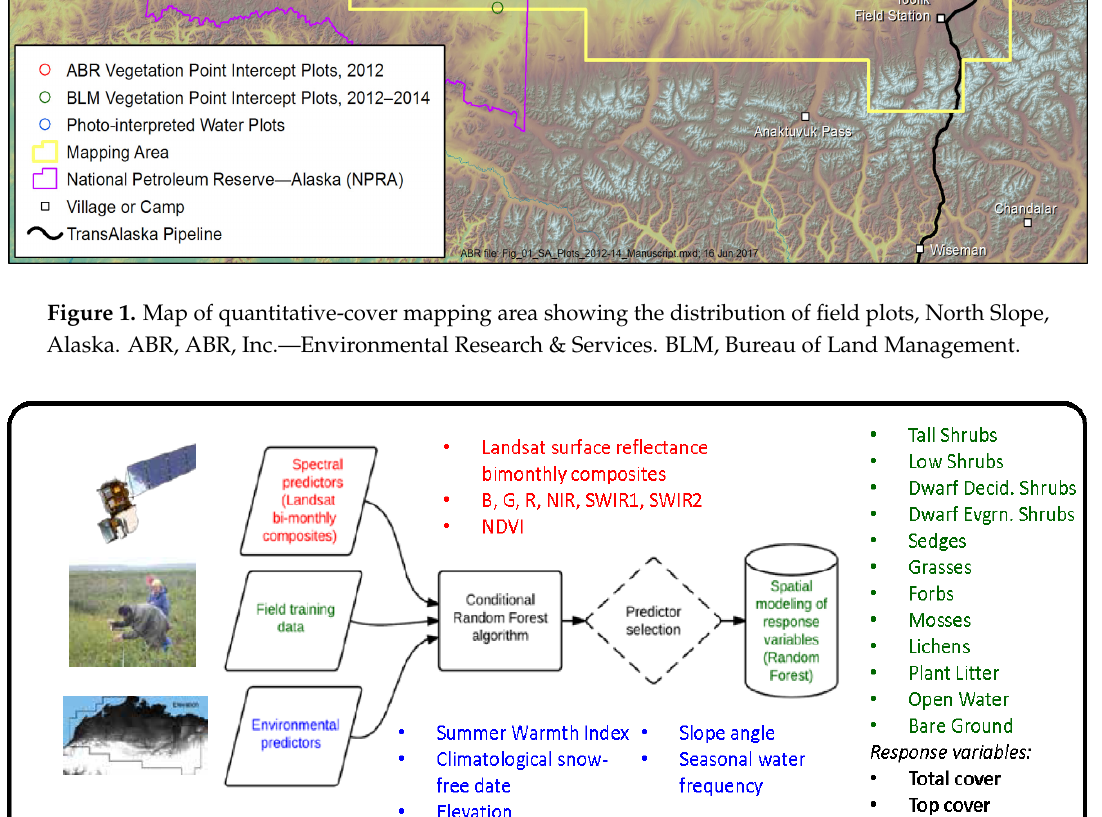
Figure 2. Overview of random forest modeling process to predict cover of plant functional types (PFTs), litter and nonvegetated cover types, North Slope, Alaska. Table 1. Tundra PFTs and other cover types used for cover modeling, North Slope, Alaska. PFT or Other Cover Type